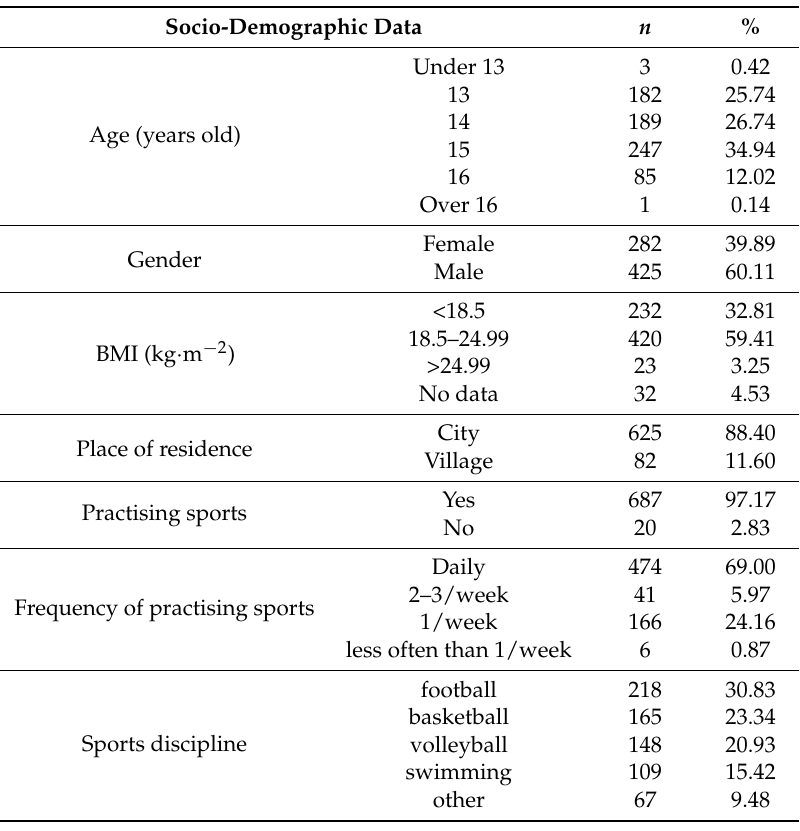
Table 1. Participants’